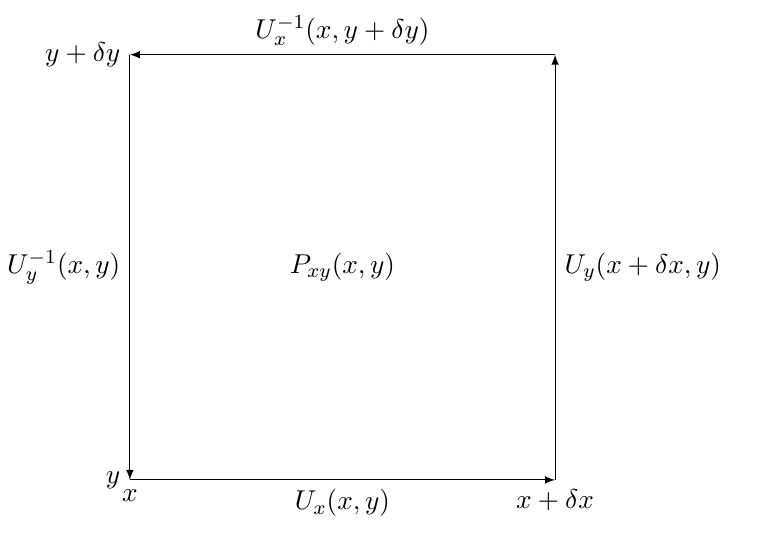
Figure 27 . A diagram of a Wilson